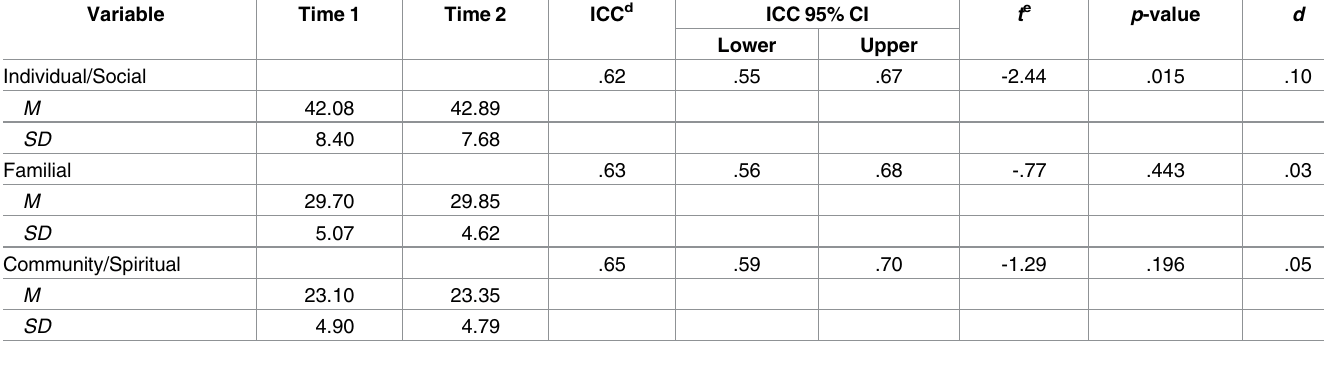
Individual/Social